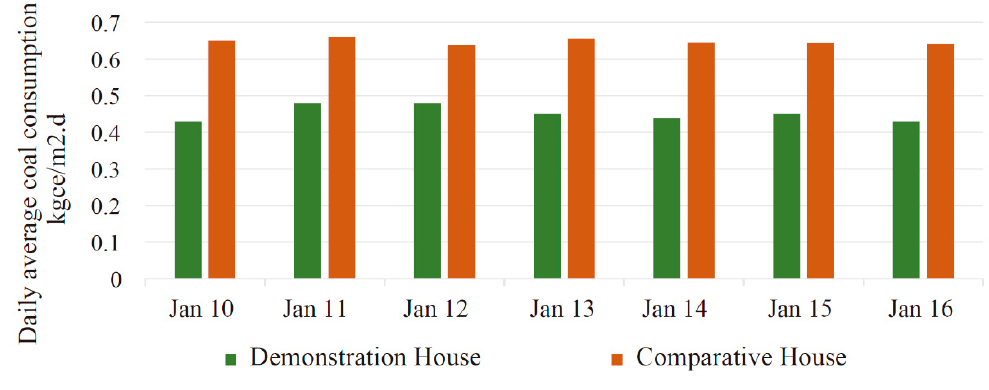
Figure 20. Comparison of the building energy consumption.